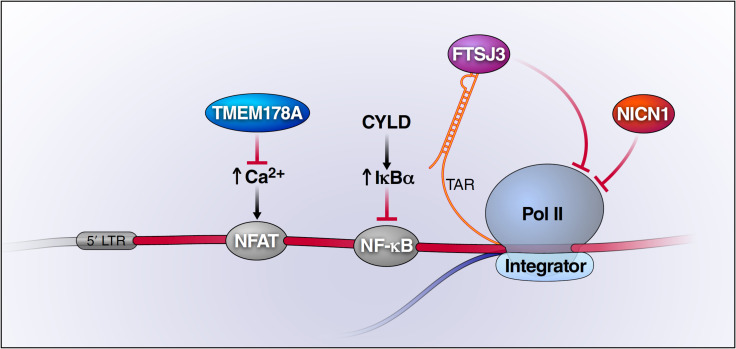
Graphic Summary of the Likely Action of New Host Latency Promoting Factors Identified in This Study.The potential mechanisms depicted are based on the previously reported mechanisms of action of these factors. See Discussion for more details.